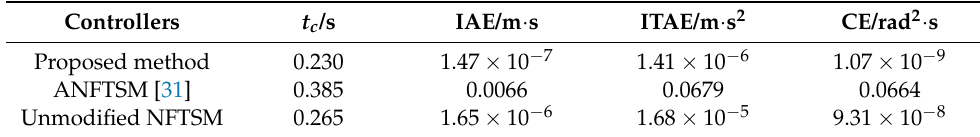
Figure 12. The outputs of N ( ξ ) and ξ . Table 4. Controller simulation